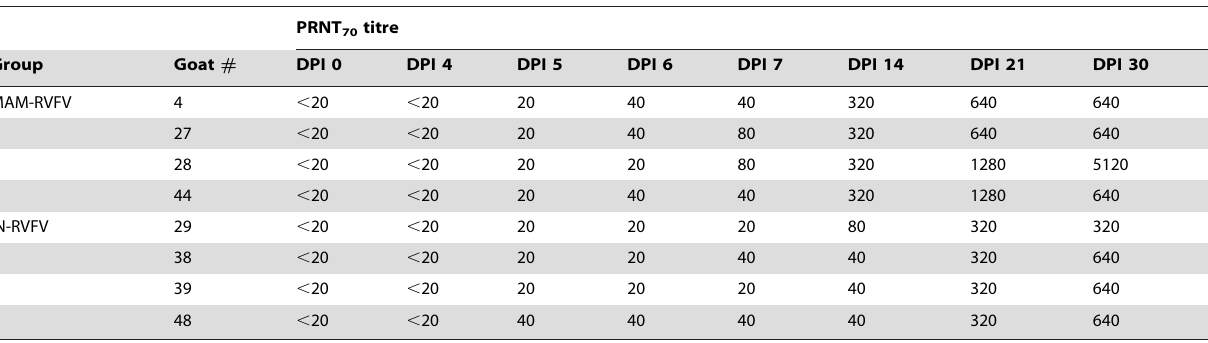
Table 1. Antibody response in RVFV-infected